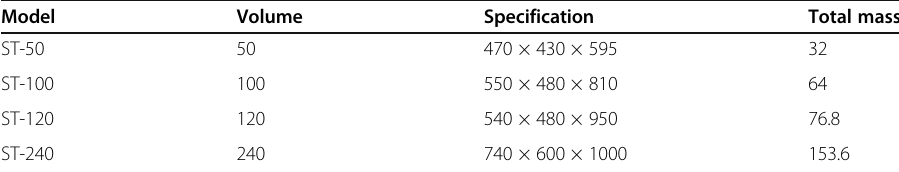
Table 4 Specific models and specifications of trash bins with different